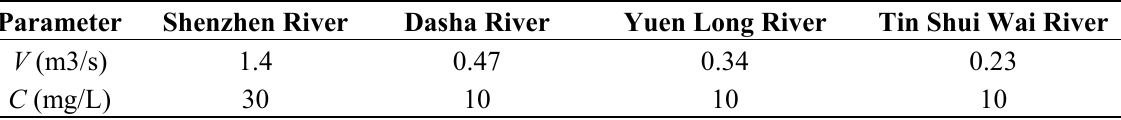
Table 1. The mean flow rates ( V ) and sediment concentration ( C ) of four